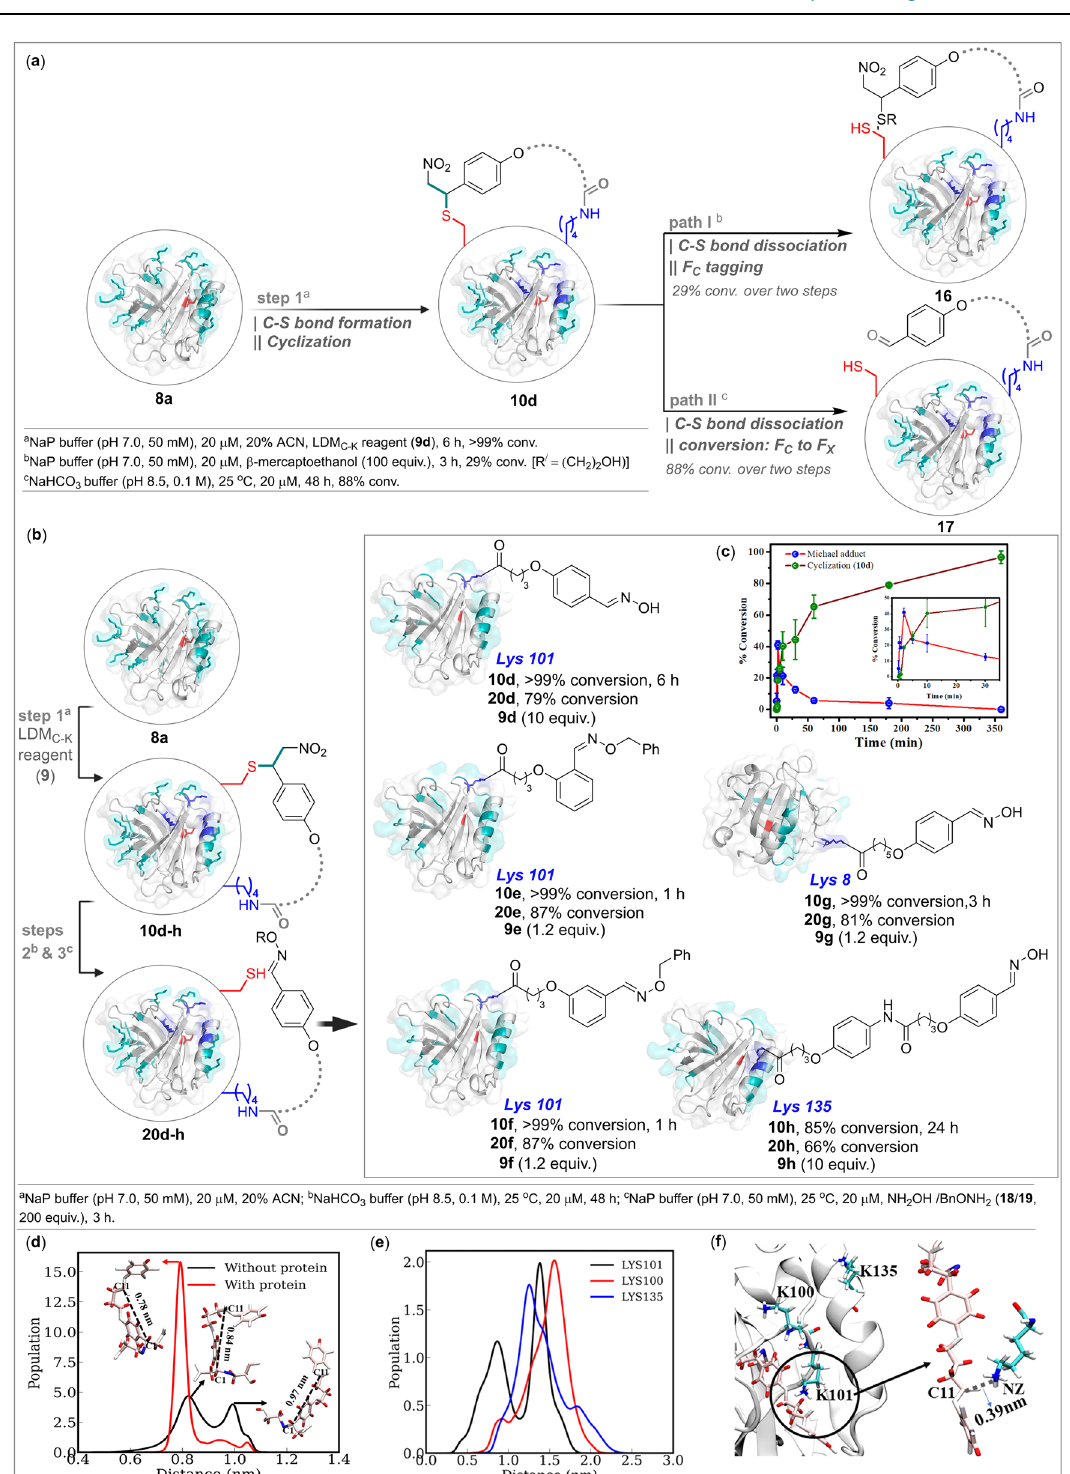
Fig.5|LDM C-K technology.a Work fl owforC-Sbondformation,cyclization,C-S/C- C bond dissociation, and F C to F X transformation. b The chemoselective, site- selective, and modular single-site labeling of a native protein ( β -lactoglobulin, BLGA, 8a ). c The plot of % conversion versus time highlights the progress of Michael addition and cyclization with BLGA in the presence of LDM C-K reagent 9d . Data are presented as mean values (±SD), n =3 independent experiments. d AdaptablerigidityofLDM C-K reagent:Probabilitydistributionforthereagent( 9d )